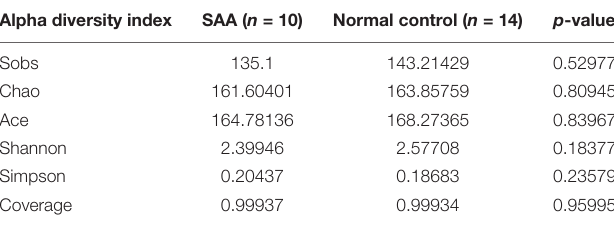
TABLE 2 | Results of the richness and diversity analysis of the intestinal microbiota.